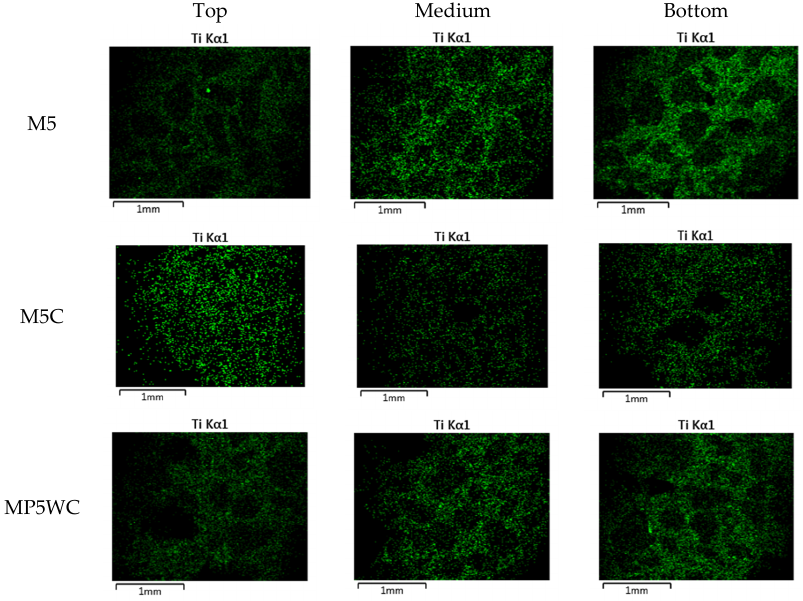
Figure 14. Ti distribution as revealed by LV-SEM/EDX for 5 wt % TiO 2 mortar specimens subjected to dynamic compaction (Green: Ti, measured in 2 mm-squares of the top, middle, and bottom surfaces).